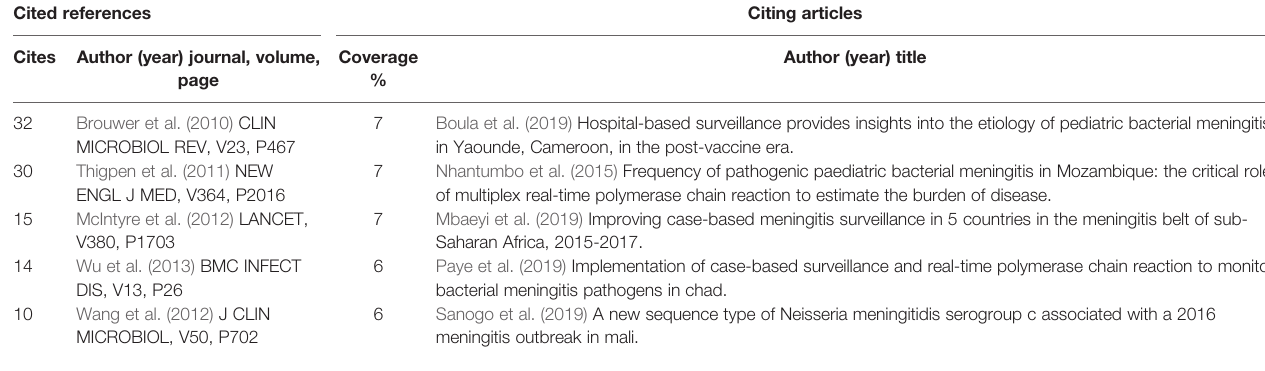
TABLE 5 | Cited references and citing articles of cluster #10 on hospital-based